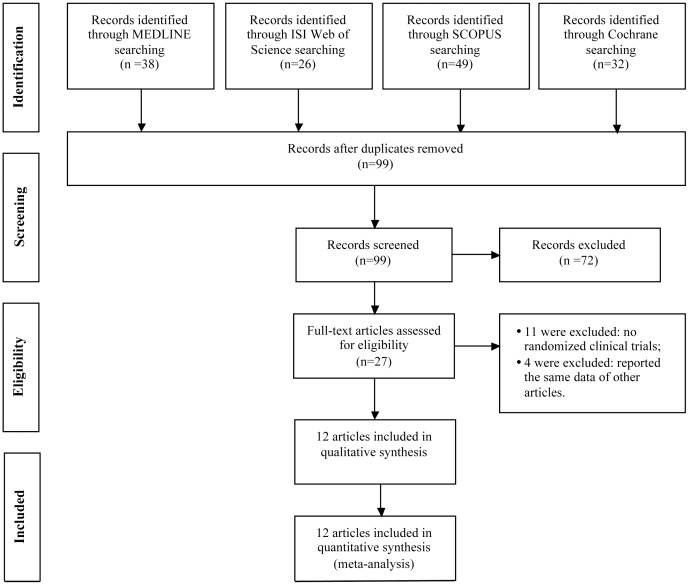
Flow chart showing the progress through the stages of the meta-analysis.